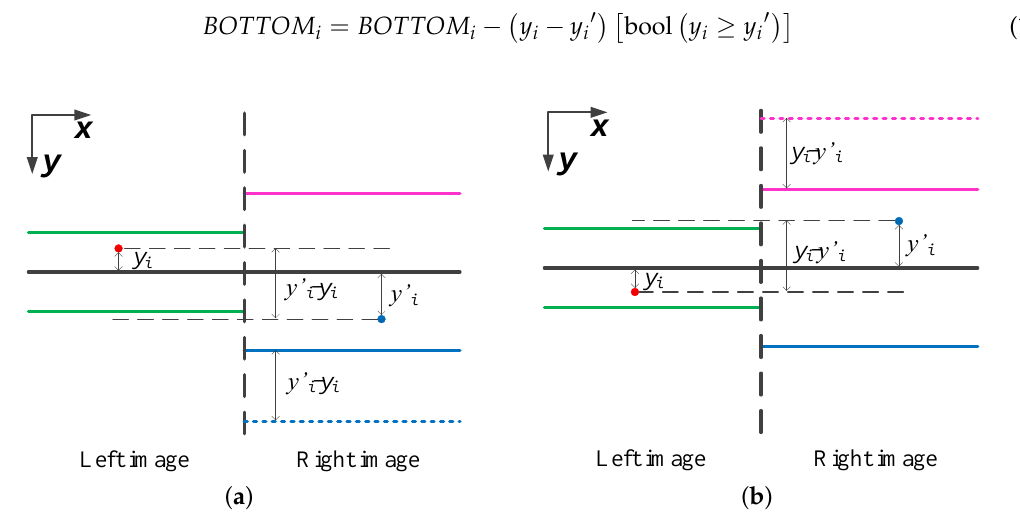
Figure 8. Two cases of adjusting the i -th searching range (black lines represent the searching line; the area between green lines are the searching range in the left image ( T ); blue and magenta lines represent the original top and bottom of the searching range in the right images (2 T ); blue and magenta dashed lines are the updated top and bottom of the searching range). ( a ) Updating the top of the searching range. ( b ) Updating the bottom of the searching